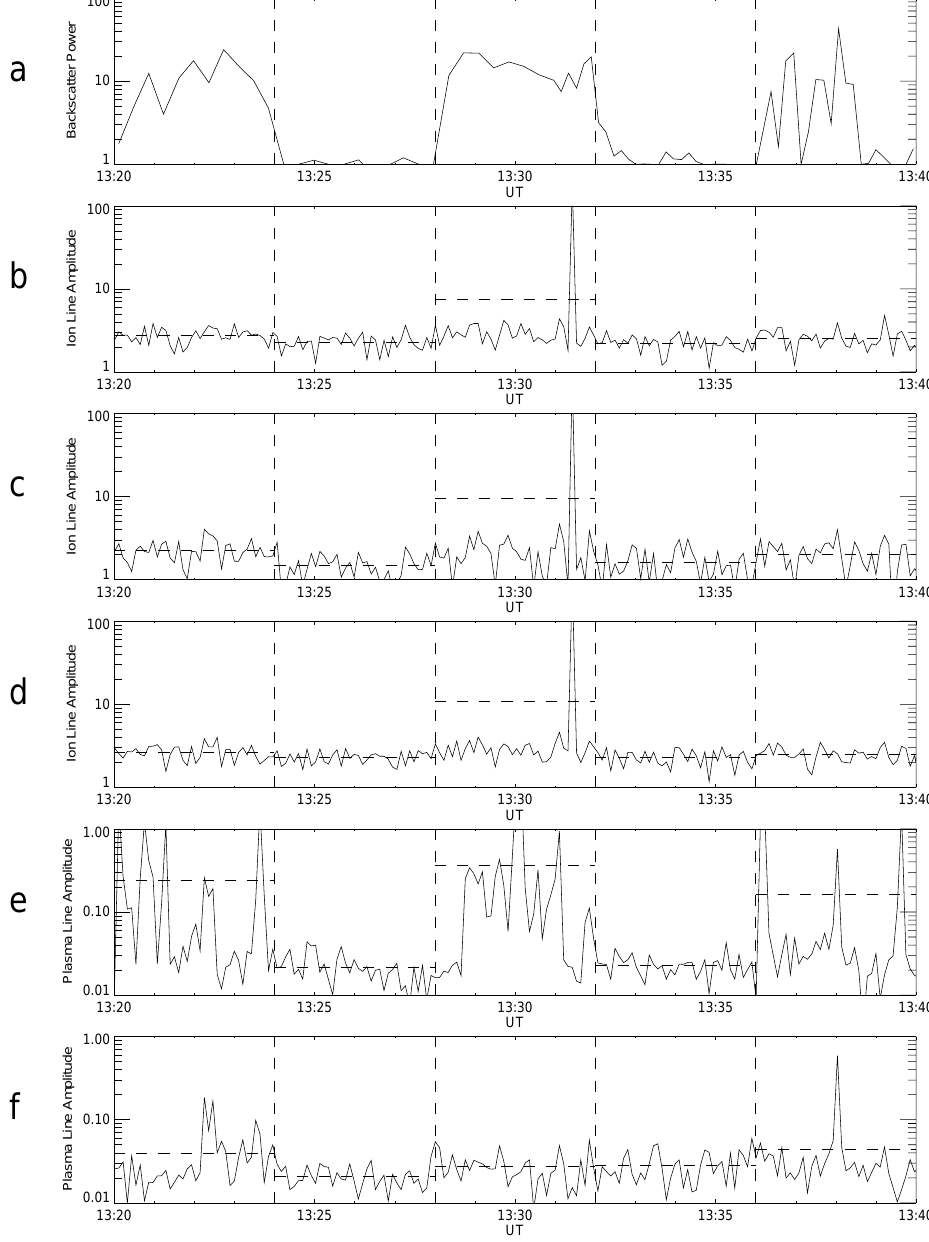
data sets, during three periods of O-mode SPEAR heating (13:12–13:16, 13:20–13:24 and 13:28–13:32 UT). The